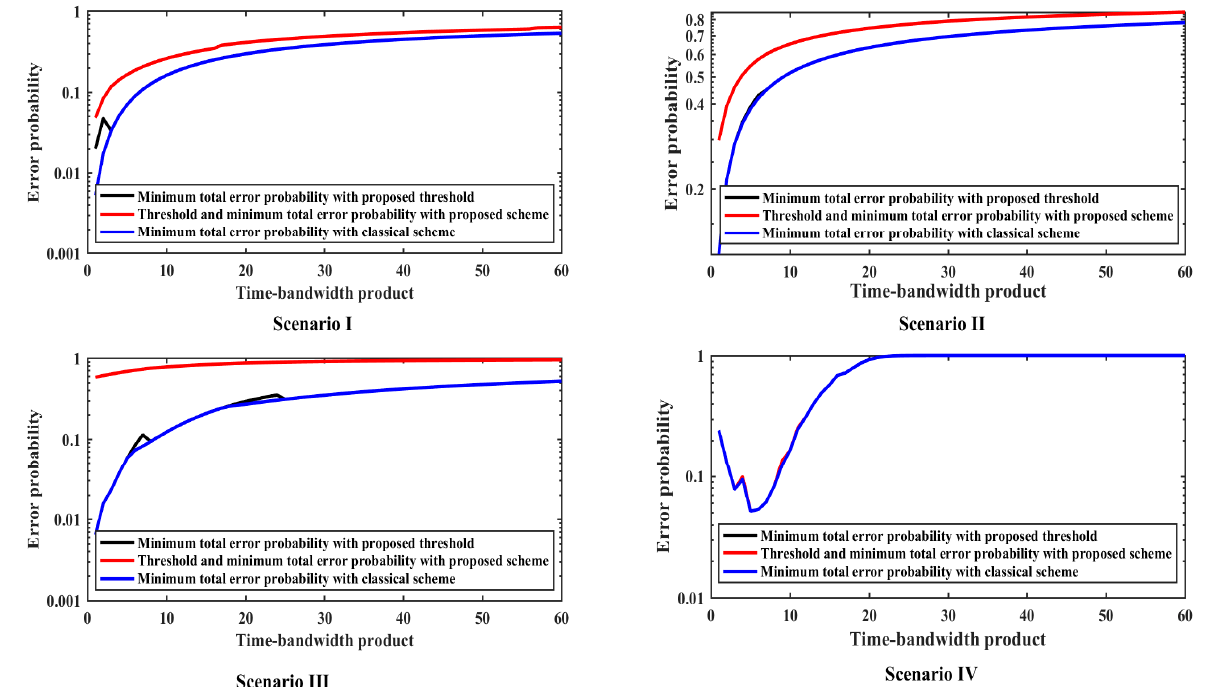
Figure 3. The total error probability comparisons under various scenarios. Scenario I, Scenario II, Scenario III and Scenario IV respectively corresponds with the scenarios mentioned above.